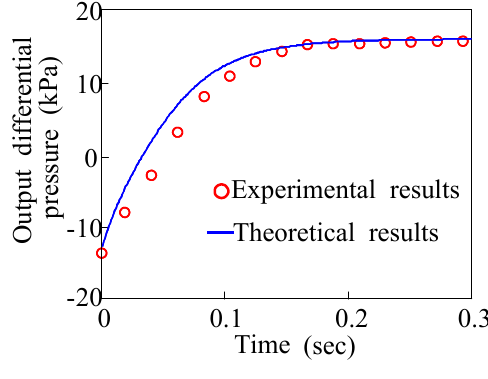
Comparison with experimental